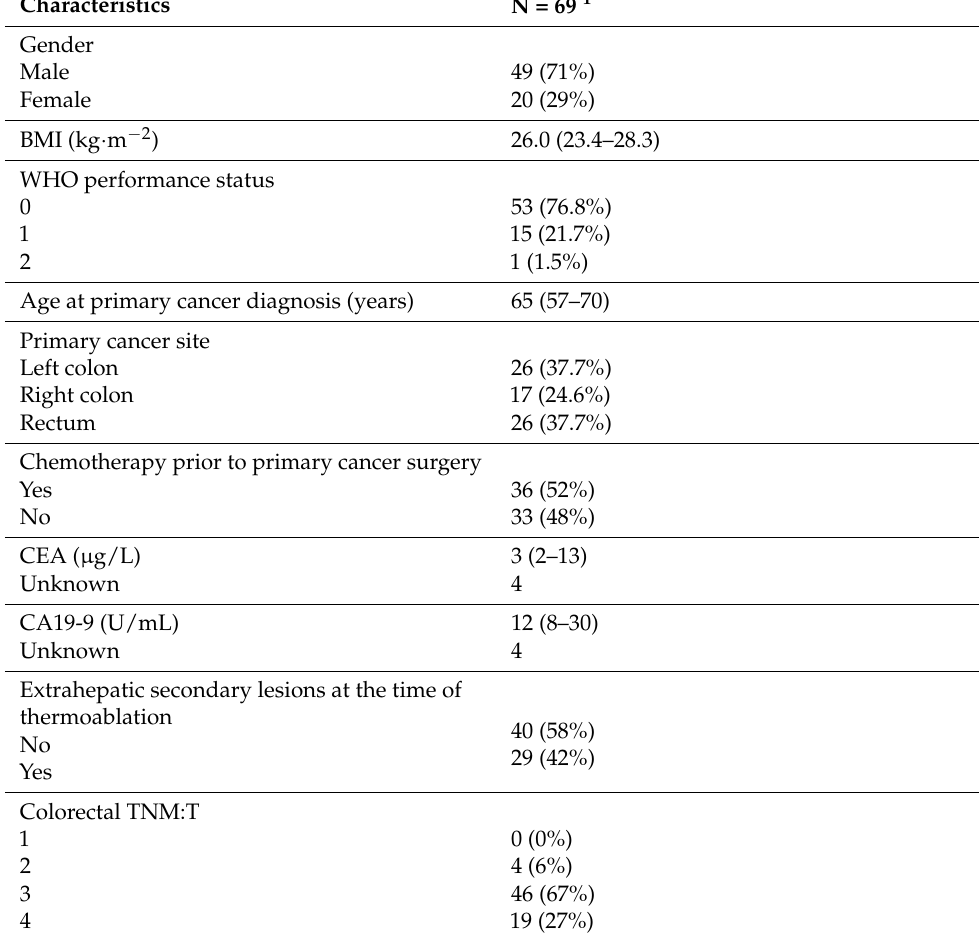
Table 1. Patient